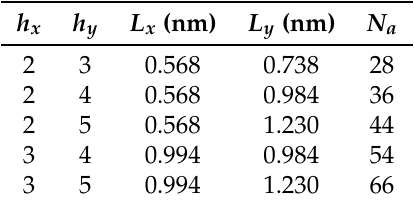
Table 1. Considered geometrical configurations of the sliding graphene sheet (dashed atoms in Figure